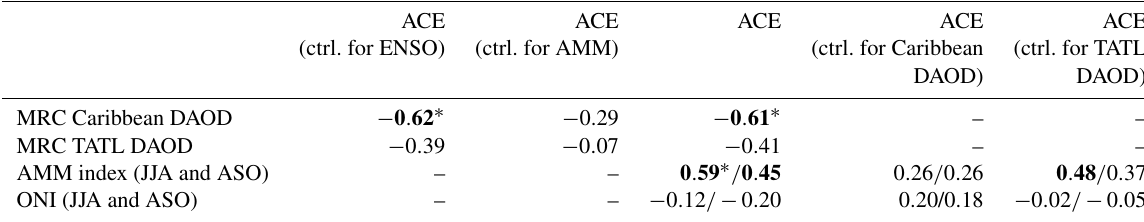
Table 6. Partial correlation matrix between MRC JJA Caribbean and tropical North Atlantic (TATL) DAOD and annual Atlantic basin-wide ACE while controlling for ENSO (using the JJA ONI) and the AMM (using JJA AMM index). Linear correlations (without controlling for the climate modes) between DAOD and ACE, AMM and ENSO indices, and ACE are also listed for comparison purposes. Correlations that are statistically significant at the 90% level are highlighted in bold, and those with asterisks are statistically significant at the 95% level. Note that the thresholds for statistical significance are different for partial correlation and linear correlation, as the degrees of freedom are different between the two. ACE ACE ACE ACE ACE (ctrl. for ENSO) (ctrl. for AMM) (ctrl. for Caribbean (ctrl. for TATL DAOD) DAOD) −